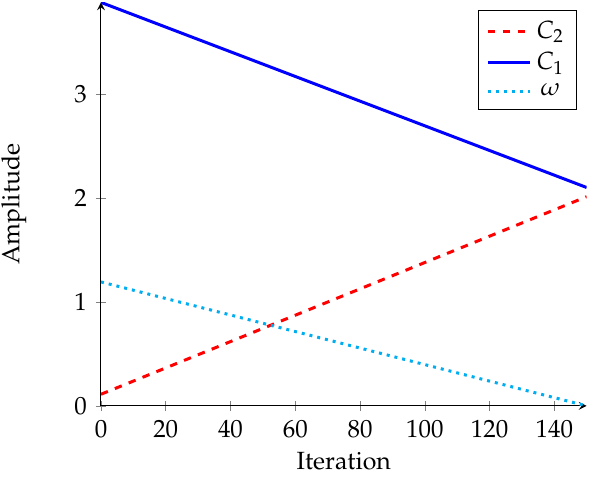
Figure 3. Changes in PSO